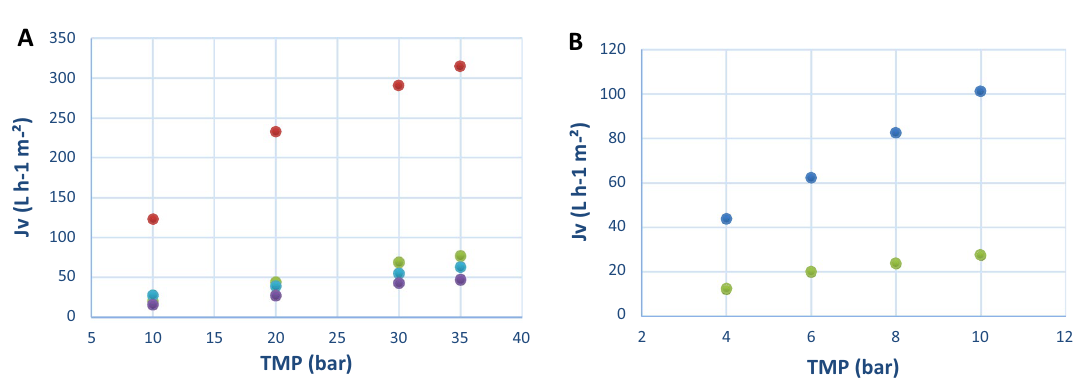
Figure 1. Structures of the coenzyme A, (CoAS) 2 , ATP, ADP and AMP.